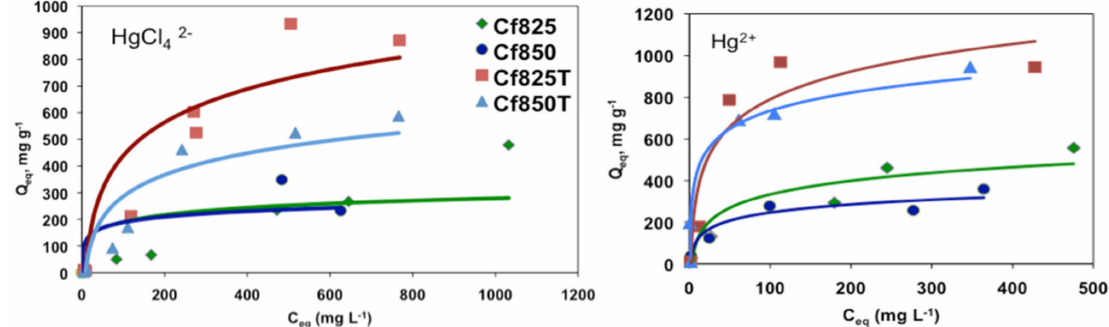
Figure 6. Representative adsorption isotherms for the adsorption of [HgCl 4 ] 2 − and Hg 2+